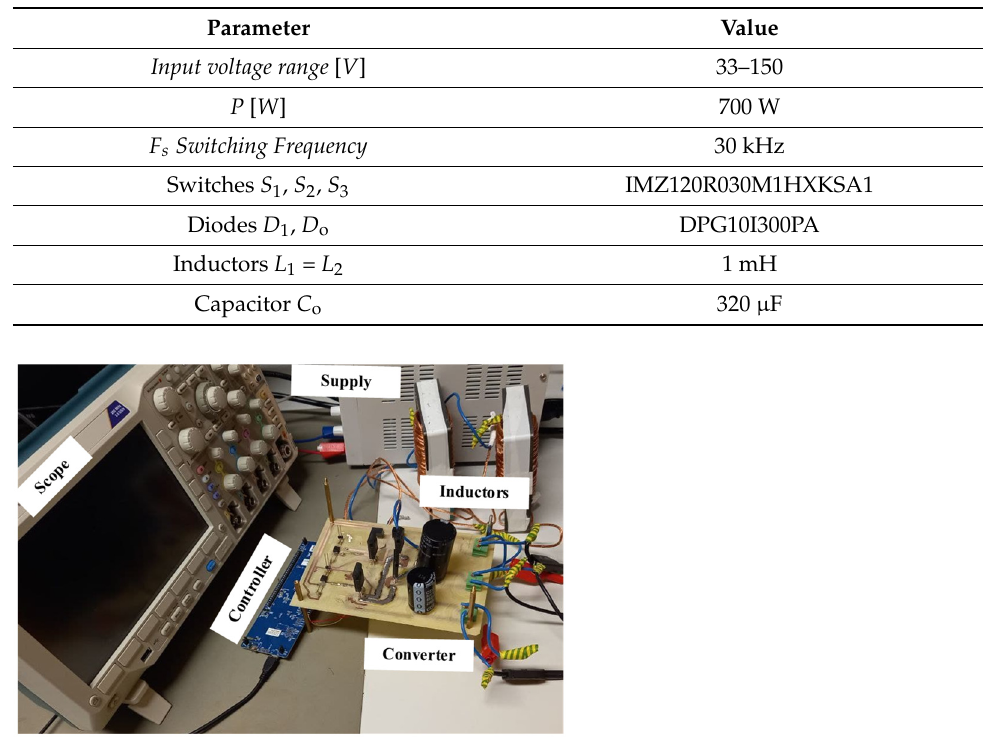
Figure 11. Experimental set-up schematic.